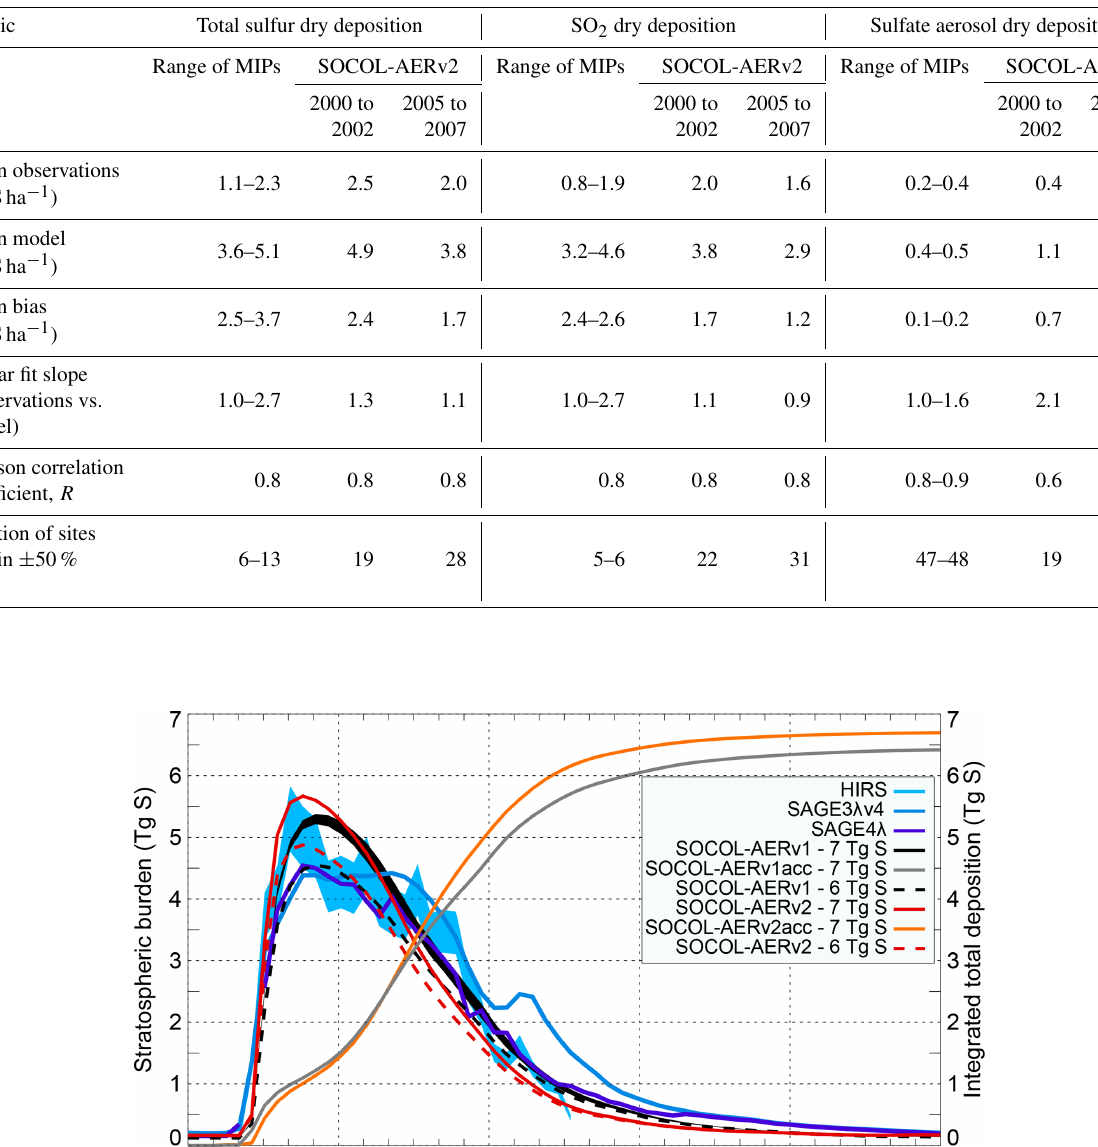
Table 4. Metrics comparing the agreement of simulated dry deposition with the WMO database in North America, separated by measurement quantity (total sulfur, SO 2 , and sulfate aerosol). Results from SOCOL-AERv2 from two time periods are compared with the range of values from past model intercomparison projects (MIP), including HTAP I (Vet et al., 2014), ACCMIP (Lamarque et al., 2013), and HTAP II (Tan et al., 2018). Note that the observational and simulation time periods covered by the other model intercomparison projects differ from SOCOL-AER in this study (see Table S1). The metrics are calculated in linear space to conform with past MIPs: linear fit slopes differ from the power regression in Fig. 6 and fractions of sites where the model is within ± 50% of observations differ from the fraction within a factor of 2 of observations listed in Fig. 6.